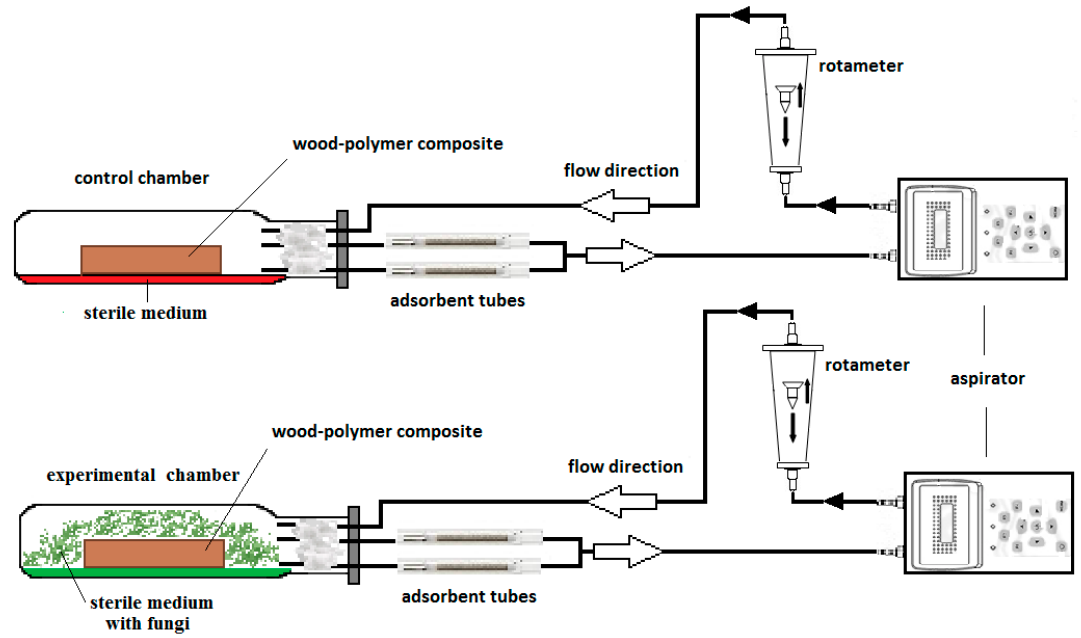
Figure 1. Schematic diagram of enclosed experimental set-up for collecting microbial volatile organic compounds (MVOCs) produced by Basidiomycetes grown on wood-polymer composite (WPC). compounds (MVOCs) produced by Basidiomycetes grown on wood-polymer composite